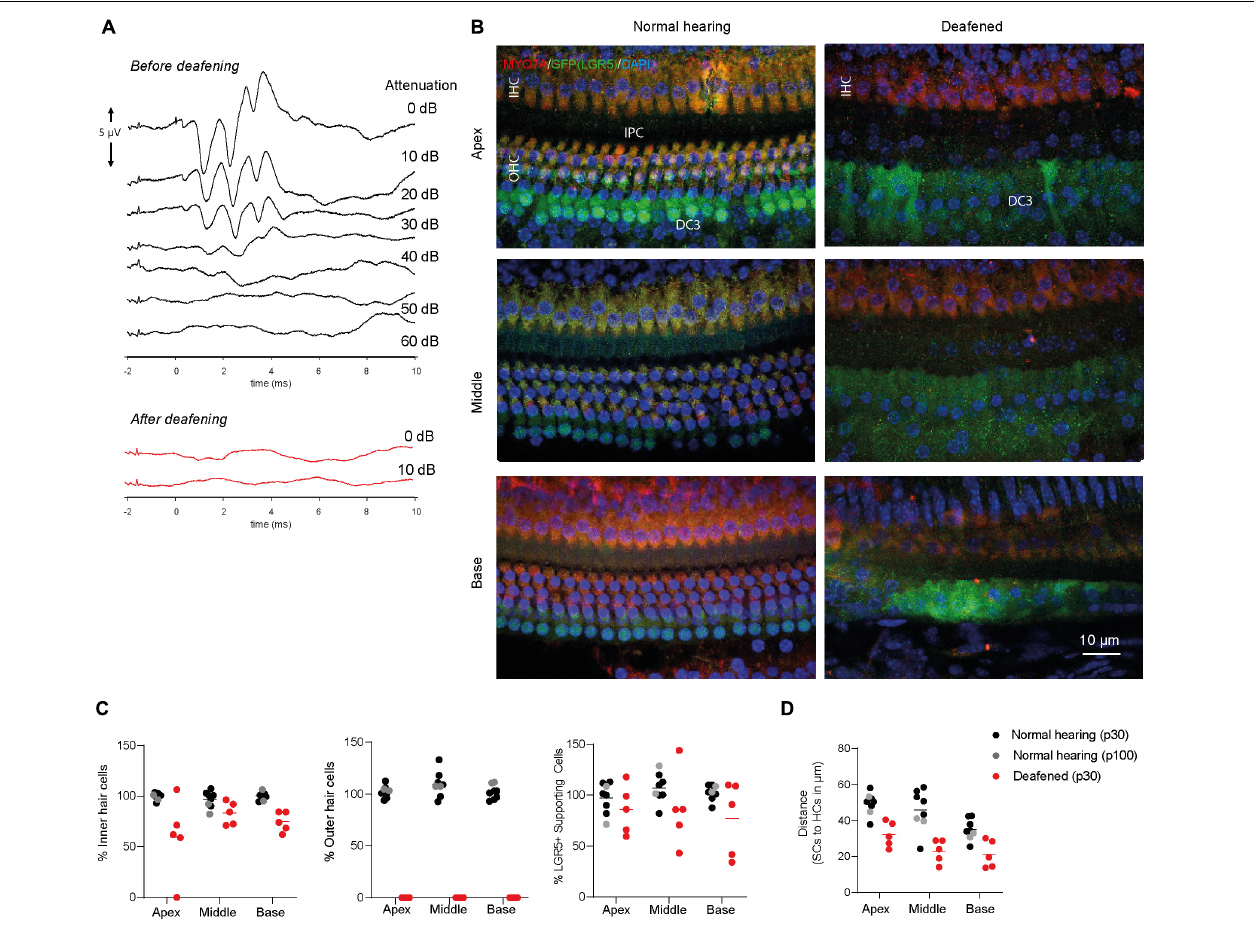
FIGURE 2 | LGR5+ supporting cells are detected in the deafened Lgr5 GFP adult mice. (A) Representative auditory brain stem responses (ABRs) of one Lgr5 GFP mouse before (in black) and 1 week after (in red) deafening. (B) Representative images of immunofluorescence microscopy of apex, middle and base in whole-mount dissections of the cochlea of Lgr5 GFP normal-hearing and deafened mice stained with myosin VIIA (MYO7A) in red, GFP (LGR5) in green and DAPI in blue. MYO7A stainings showed that the outer hair cells (OHCs) were completely abolished after deafening, with partial preservation of inner hair cells (IHCs). Compared to the normal cochlea, the GFP (LGR5) expression after deafening was still present in the third row of Deiters’ cells (DC3s) and showed a cytoplasmic sublocalization and a more diffuse staining. (C) Cell counts, in percentage, for apex, middle and base of the cochlea of normal-hearing (p30 in black and p100 in gray) and deafened (p30) Lgr5 GFP mice. (D) Distance in µ m from GFP + SCs to MYO7A+ IHCs. Bar = 10 µ m. n normal hearing ( p30 ) = 6; n normal hearing ( p100 ) = 2 n deafened ( p30 ) = 5,